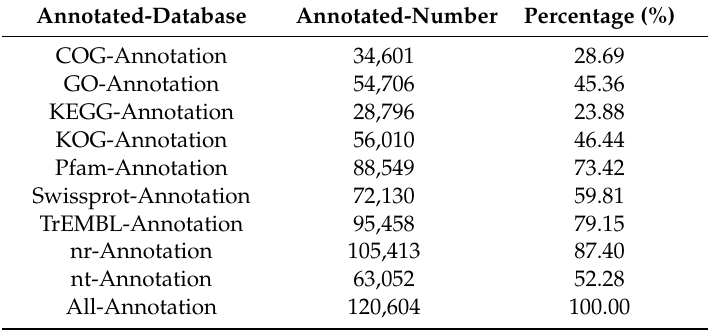
Table 1. Pitaya long-read sequencing transcriptome annotation with di ff erent